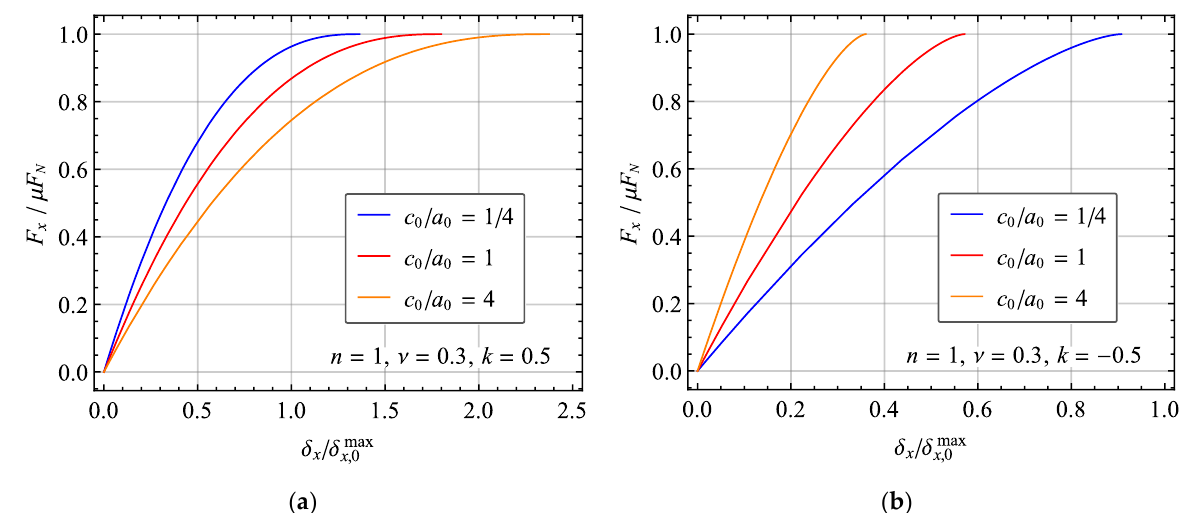
Figure 5. Influence of the characteristic depth on the normalized tangential force as a function of the normalized tangential displacement, in the case of a conical initial gap function and ( a ) a positive exponent of elastic inhomogeneity, ( b ) a negative exponent of elastic inhomogeneity.